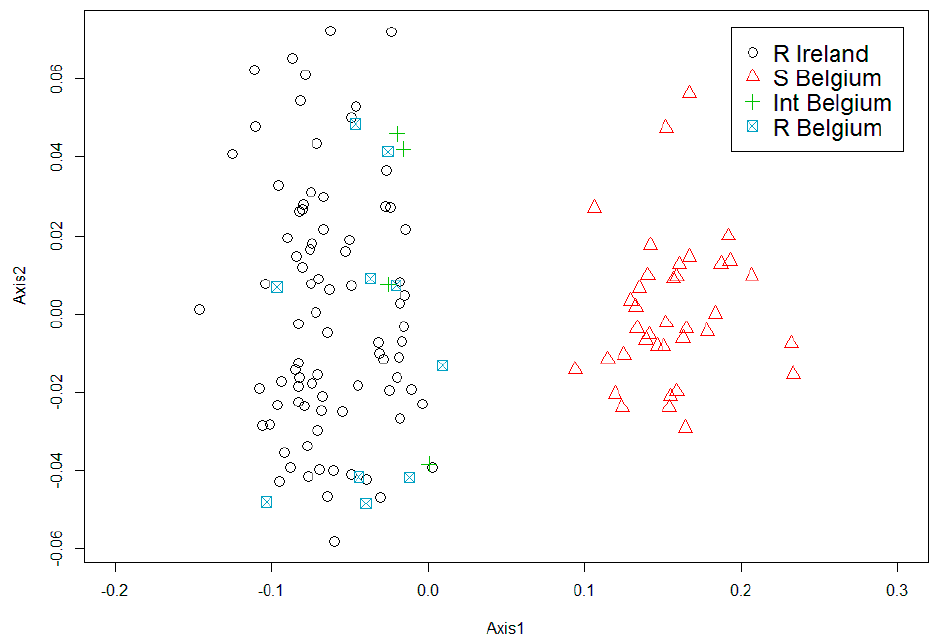
Figure 3. A principal component analysis (PCA) of the ratio between shell measurements for Corbicula form R from all Irish sites and forms R, S and individuals with intermediate morphotypes between form R and S (Int), from the River Meuse in Belgium.